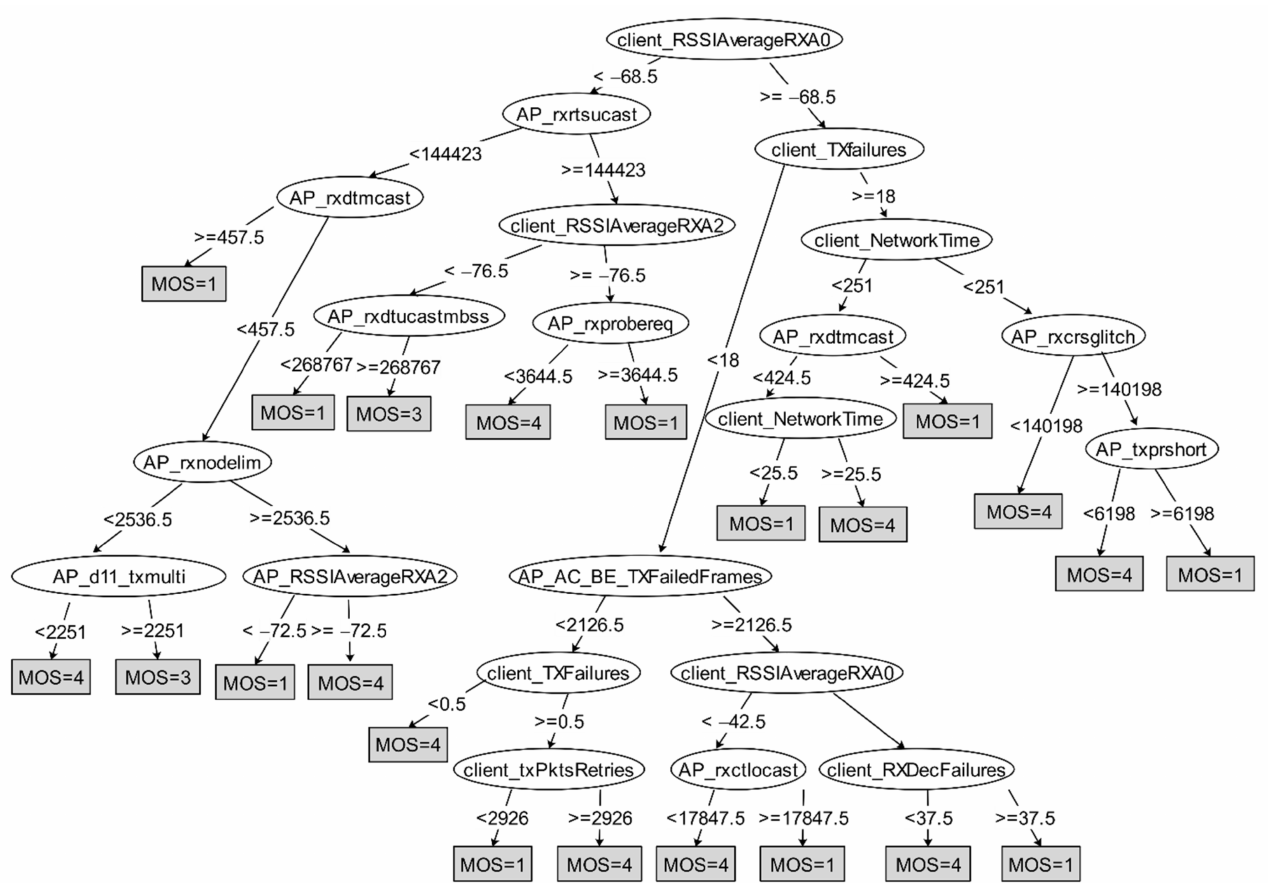
Figure 5. Tree model for REPTree trained with 2ax dataset to classify wireless quality into MOS